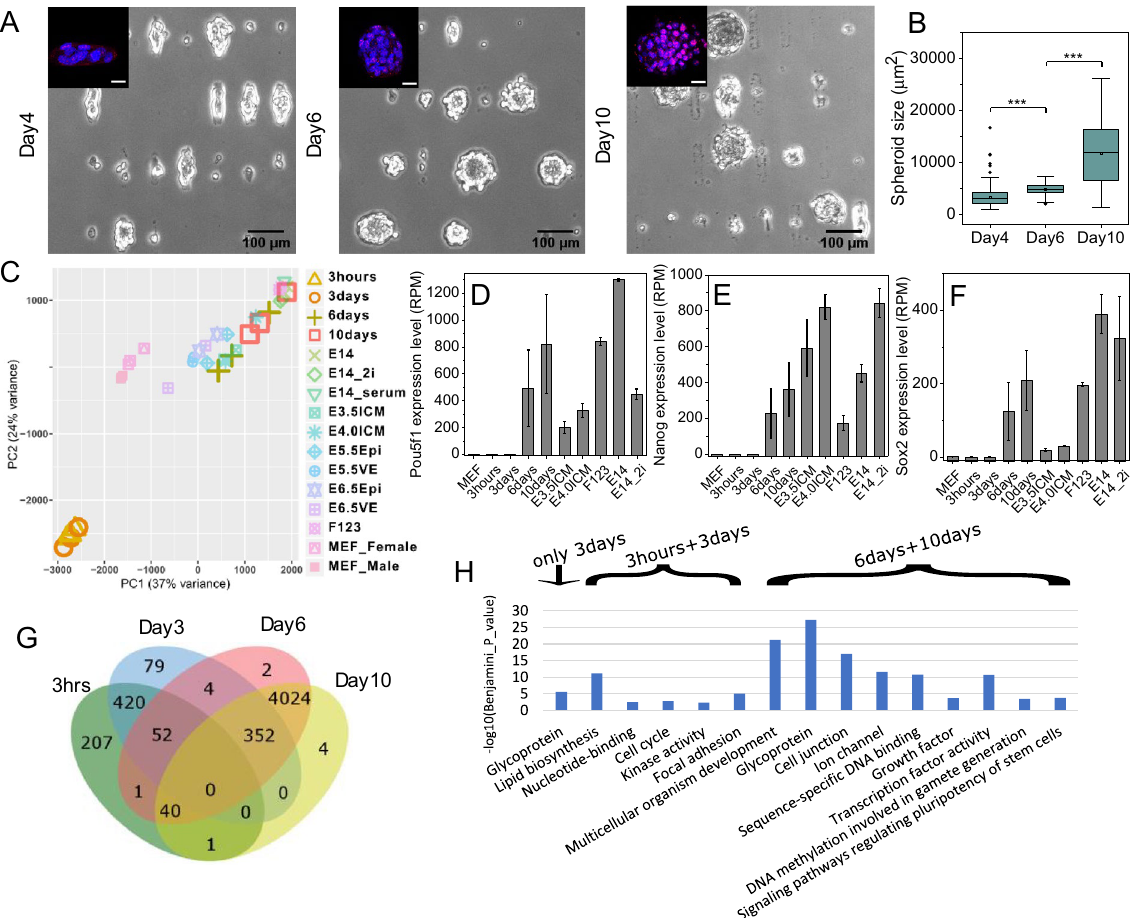
Figure 1. Global gene expression analysis of fibroblast cells grown under lateral confinement reveals their de-differentiation. (A) Differential interference contrast images of cells grown under lateral confinement for 4, 6, or 10 days. The insets show fluorescence images of Oct4 staining (in red) and nuclei (in blue). Inset scale bar is 20 um. ( B ) The box plot of spheroid sizes on days 4, 6, and 10 reveals that cells organize into a spheroid on the micropattern, which progressively increases in size. *** P < 0.001; n = 499, 440, 153 for day4, 6, and 10 respectively; two-sided Student’s t-test was used. ( C ) Principal Component Analysis of the gene expression profile shows change of cell states through de-differentiation. Genes involved in this analysis are differentially expressed with adjusted p value < 0.01 and |log2 Fold change|> 2. ( D , E , F ) Bar plot graphs of Oct4, Nanog, or Sox2 gene expression (RPM) over four time points during de-differentiation and how it compares to other cell types. MEF: mouse embryonic fibroblasts; E3.5ICM: E3.5 inner cell mass; E4.5ICM: E4.5 inner cell mass; F123: F123 cell line; E14: ES-E14TG2a cell line cultured in mouse ES cell media; E14_2i: ES-E14TG2a cell line cultured in 2i condition. Error bars represent ± SD. ( G ) Venn diagram showing the number of up-regulated genes over the four time points during de-differentiation. For example, there are 4024 genes up-regulated on day6 and day10 compared to the 3 h and day3 timepoints. Up-regulated genes have FDR (adjusted p value) < 0.01. ( H ) Functional annotation of genes that are overexpressed on the day3 timepoint (207 genes), at both 3 h and day3 timepoints (420 genes), and at both day6 and day10 timepoints (4024